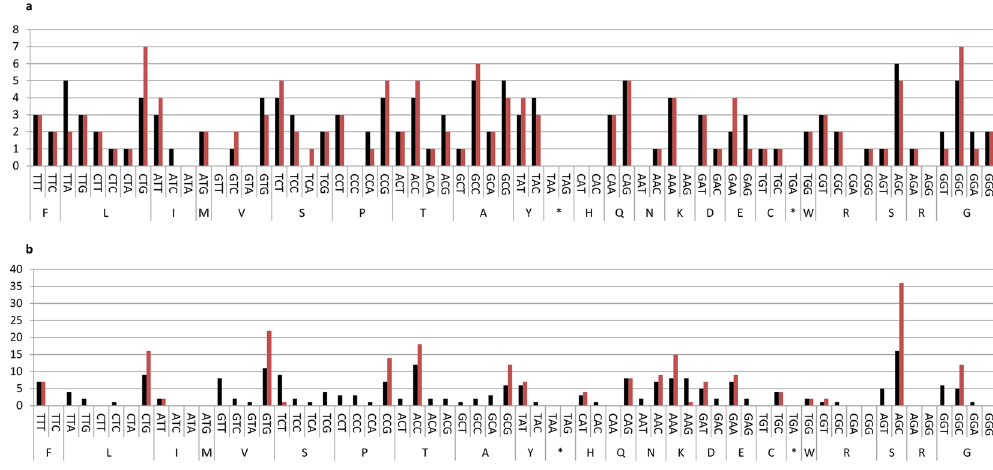
Figure 3. The total codon counts in the variable segments and the constant segments of Fab0 and sFab. ( a ) Codon counts in the variable segments and ( b ) the constant segments. The black bars show the count of each codon in Fab0 and red bars in